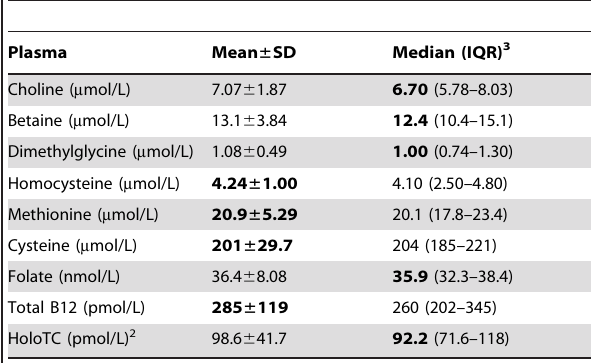
Table 1. Plasma methyl nutrients and metabolites, folate and vitamin B12 at 16 weeks of gestation 1